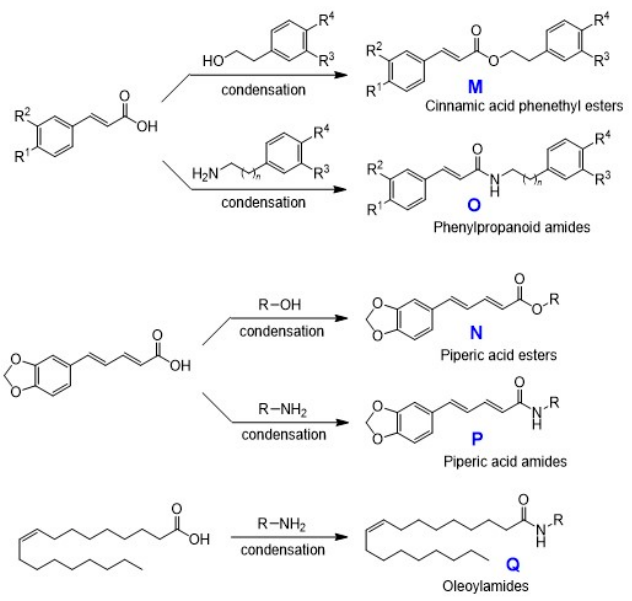
Figure 6. Synthesis of esters and amides.